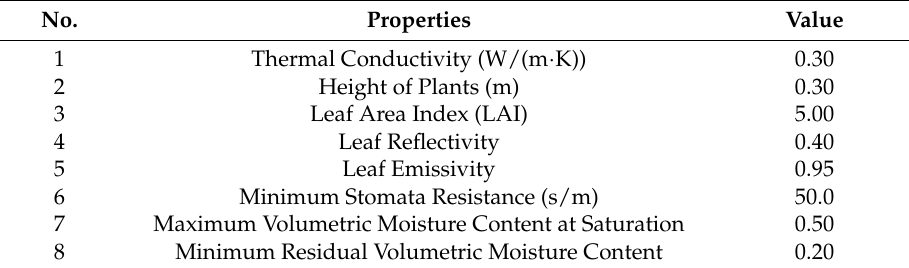
Table 3. Extensive green roof model parameters for input in